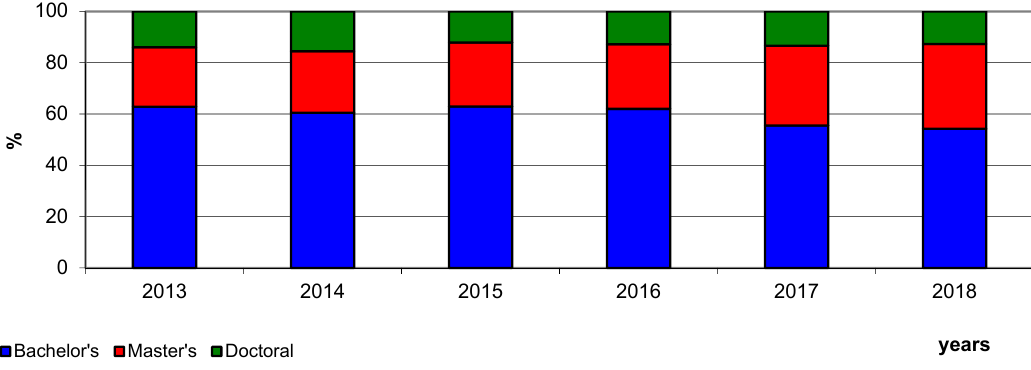
Figure 6. Structure of education in the fields of electricity and energy in Czechia in 2013–2018.